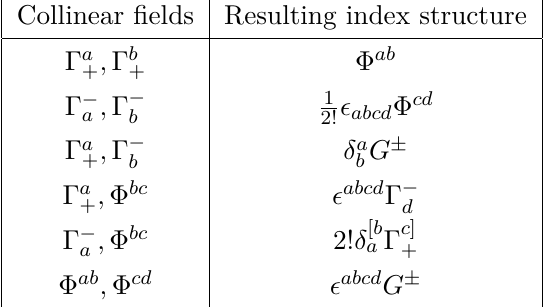
Table 1 . Index structure in collinear limit in N = 4